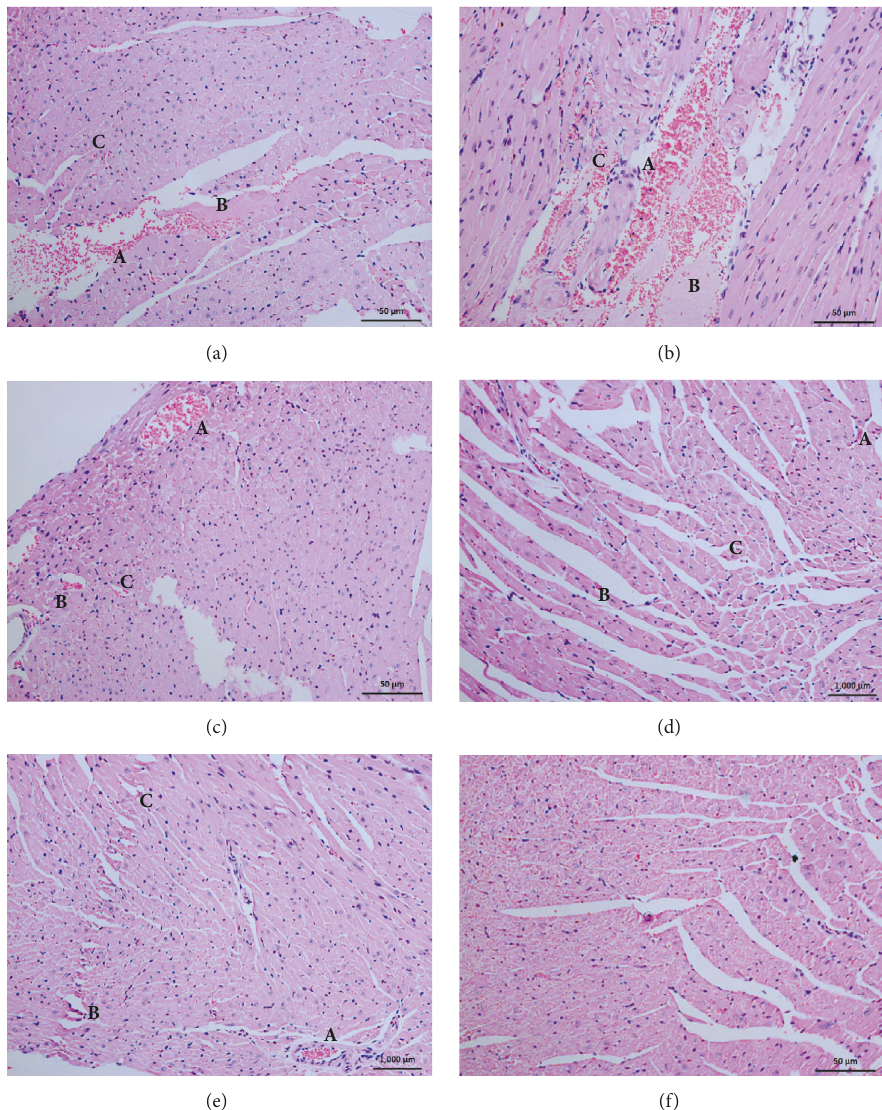
Figure 3: Histopathological changes in cardiac muscles, after 3hr from injection of N. naja venom from (a) Western Region Population, (b) Central Region Population, (c) North Region Population, (d) Sabaragamuwa Region Population, (e) Southern Region Population, and (f) Control. (A) Congestion. (B) Necrotic fibers. (C)